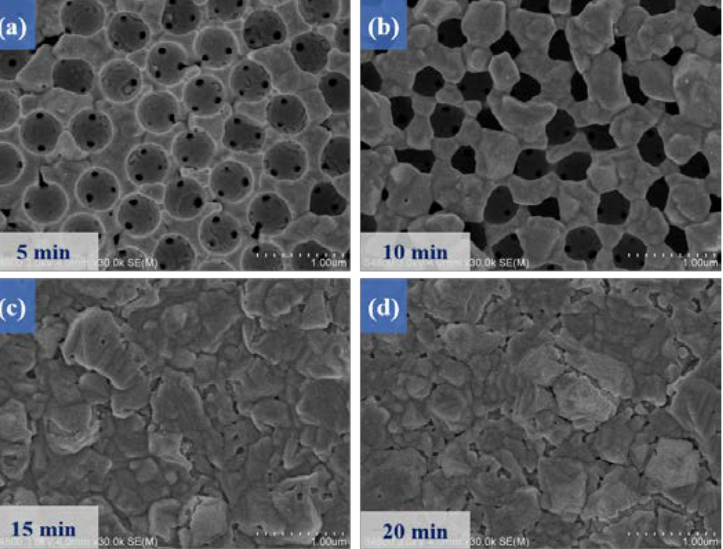
Figure 4. Top-view of SEM images of MoS 2 /Ni-IOS microelectrode samples fabricated with different electrodeposition times, where the electrodeposition parameter was − 10 mA/cm 2 , and the deposition times were ( a ) 5 min, ( b ) 10 min, ( c ) 15 min, ( d ) 20 min.